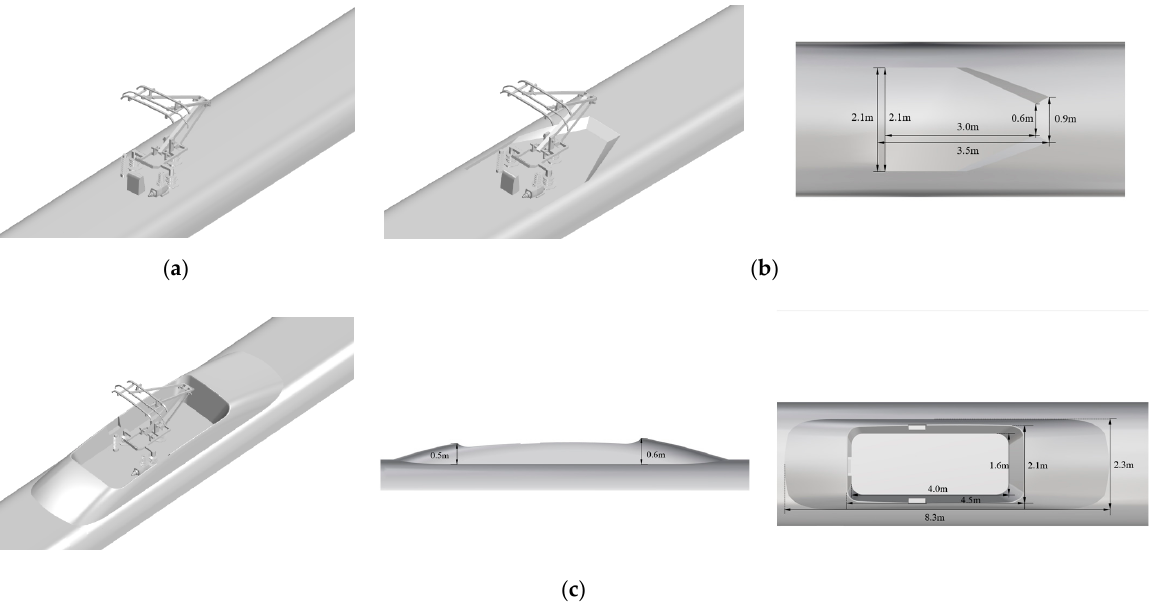
Figure 6. Sketch of the computational domain.